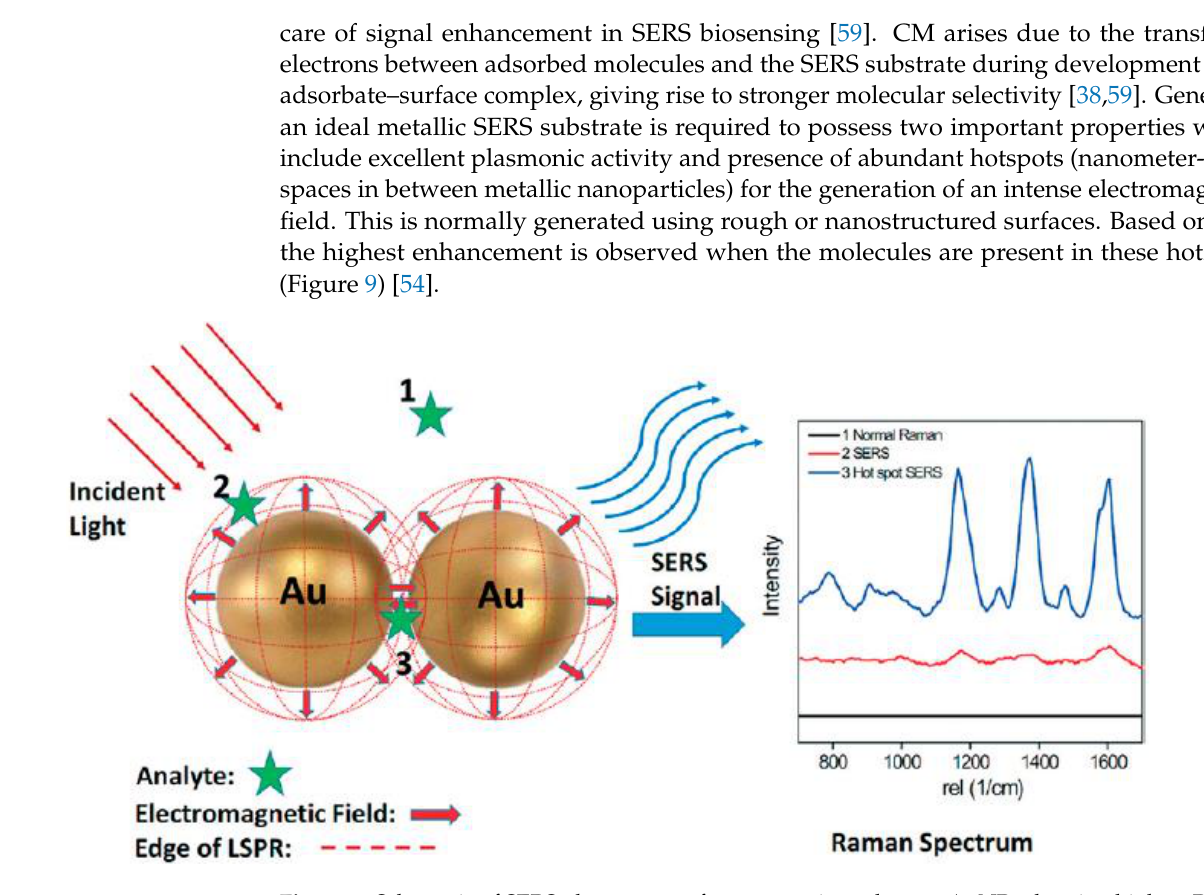
Figure 9. Schematic of SERS phenomenon for an organic analyte on AuNPs showing highest Raman intensity when the analyte is present in the hotspot. Figure adapted from [61].